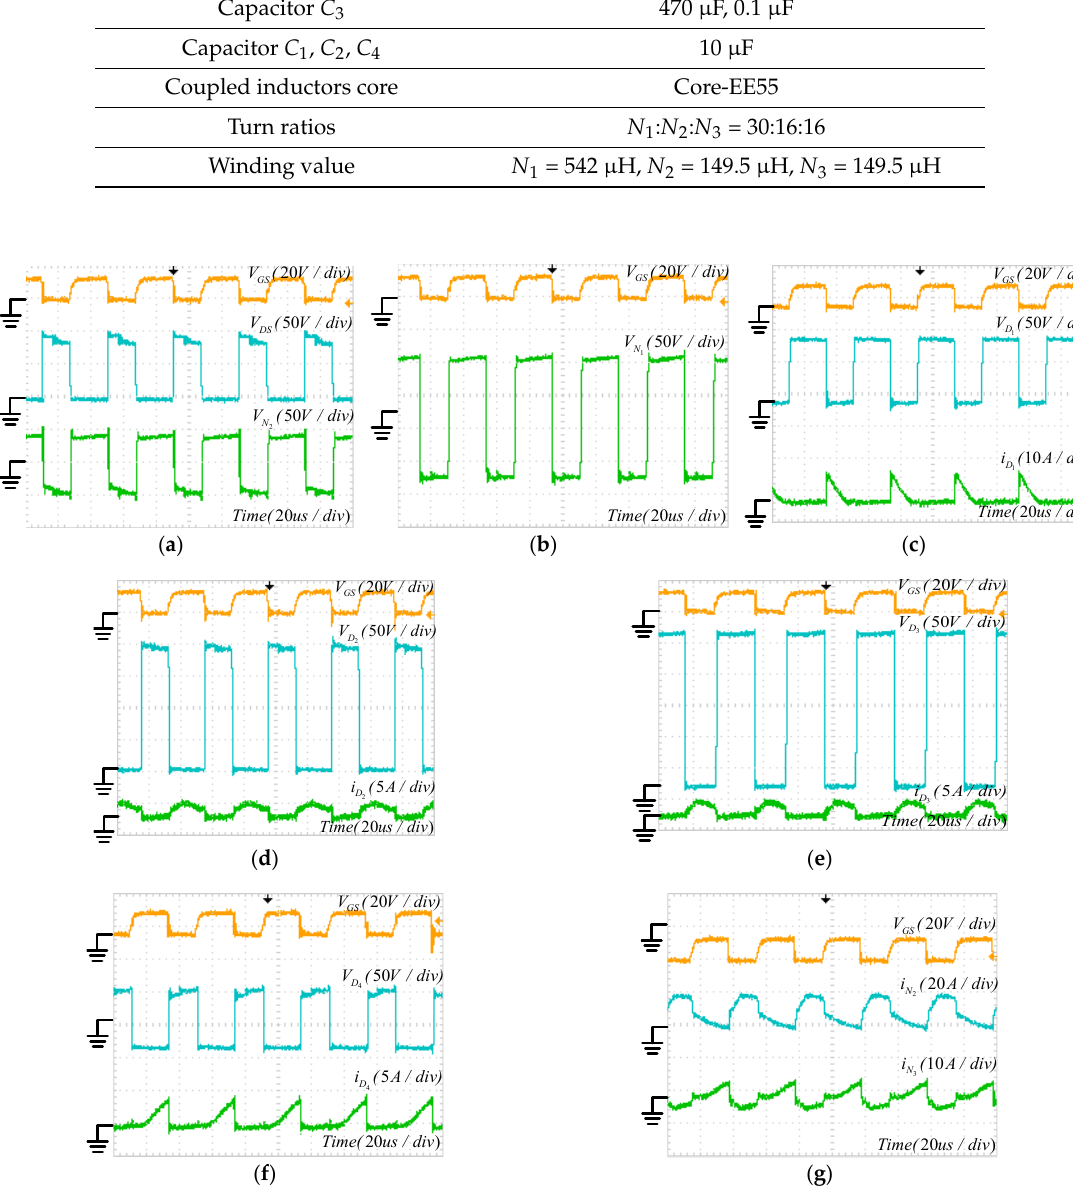
Figure 7. Experimental waveforms of the proposed converter. ( a ) Voltages of drive signal, switch and winding N 2 ; ( b ) voltages of drive signal and winding N 1 ; ( c ) voltages of drive signal, voltage and current of diode D 1 ; ( d ) voltages of drive signal, voltage and current of diode D 2 ; ( e ) voltages of drive signal, voltage and current of diode D 3 ; ( f ) voltages of drive signal, voltage and current of diode D 4 ; and ( g ) voltages of drive signal, current of windings ( N 2 and N 3 ).